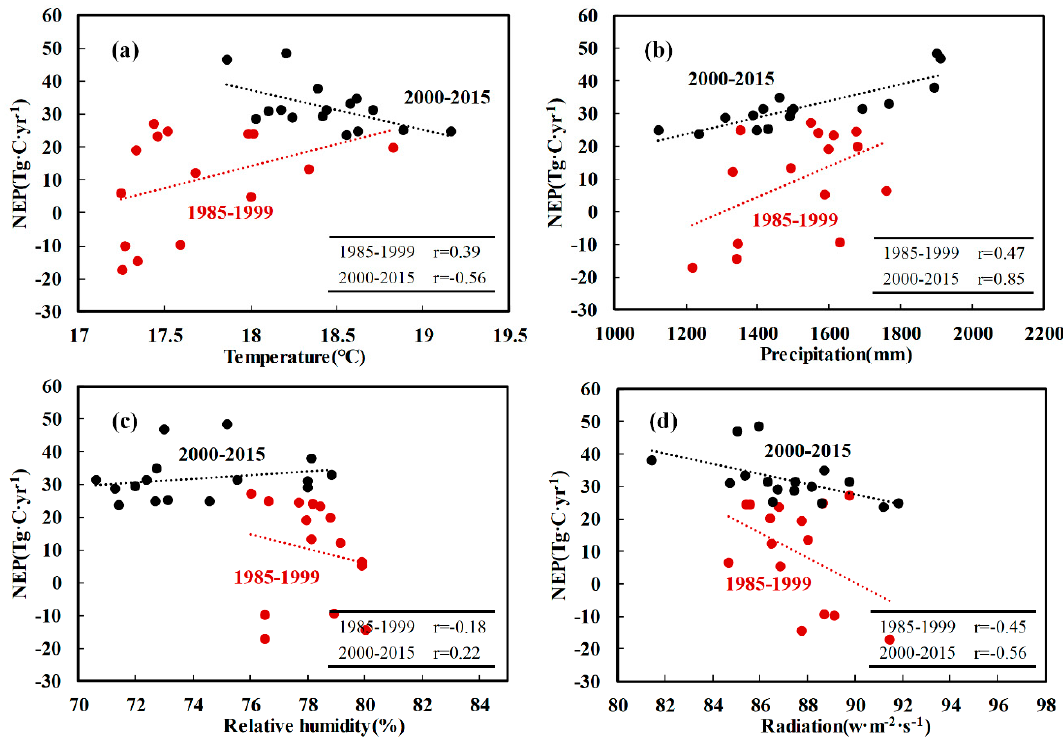
Figure 10. Relationship between NEP and ( a ) temperature ( b ) precipitation ( c ) relative humidity ( d ) radiation.